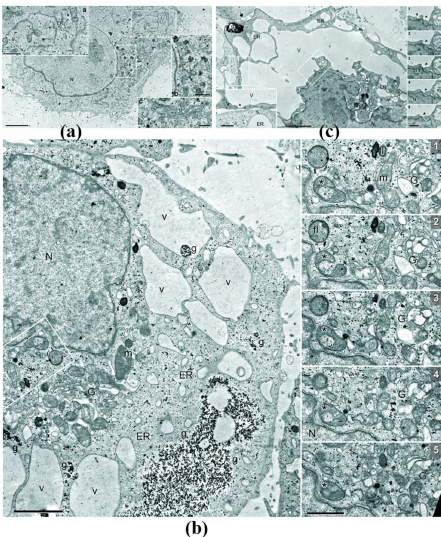
Figure 3. Changes in the ultrastructure of HEp-2 cells caused by incubation for 4 h in the culture medium containing 1 mM DDC and 25 µ M B 12b . ( a ) Ultrastructure of a control cell. Selected areas enlarged in inserts a, b, and c. Scale bars: 3 µ m in the overview, 1 µ m in a and b, and 0.5 µ m in c. ( b ) Ultrastructure of a cell with moderate changes after incubation. Scale bars: 2 µ m in the overview and 1 µ m in series. ( c ) Ultrastructure of a cell with severe changes after the incubation. For distinguishing the cell from the extracellular space, the plasma membrane of the cell is marked with a dashed line. Scale bars: 2 µ m in the overview and 0.5 µ m in the left insert and in series. N, nucleus; n, nucleolus; ER, endoplasmic reticulum; G, Golgi apparatus; m, mitochondria; g, glycogen granules; fl, secondary lysosomes; afl, autophagolysosomes; v, vacuole-like ER sacks.